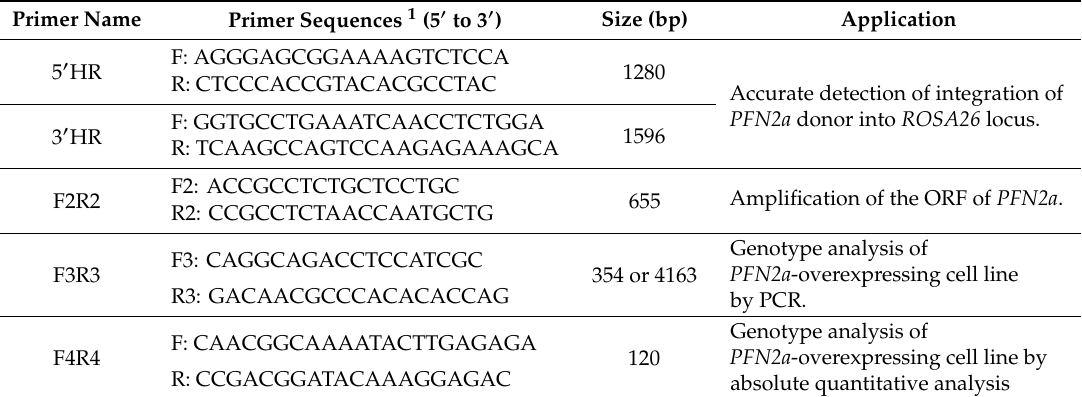
Table 2. Primers used for identifying the PFN2a -overexpressing cell